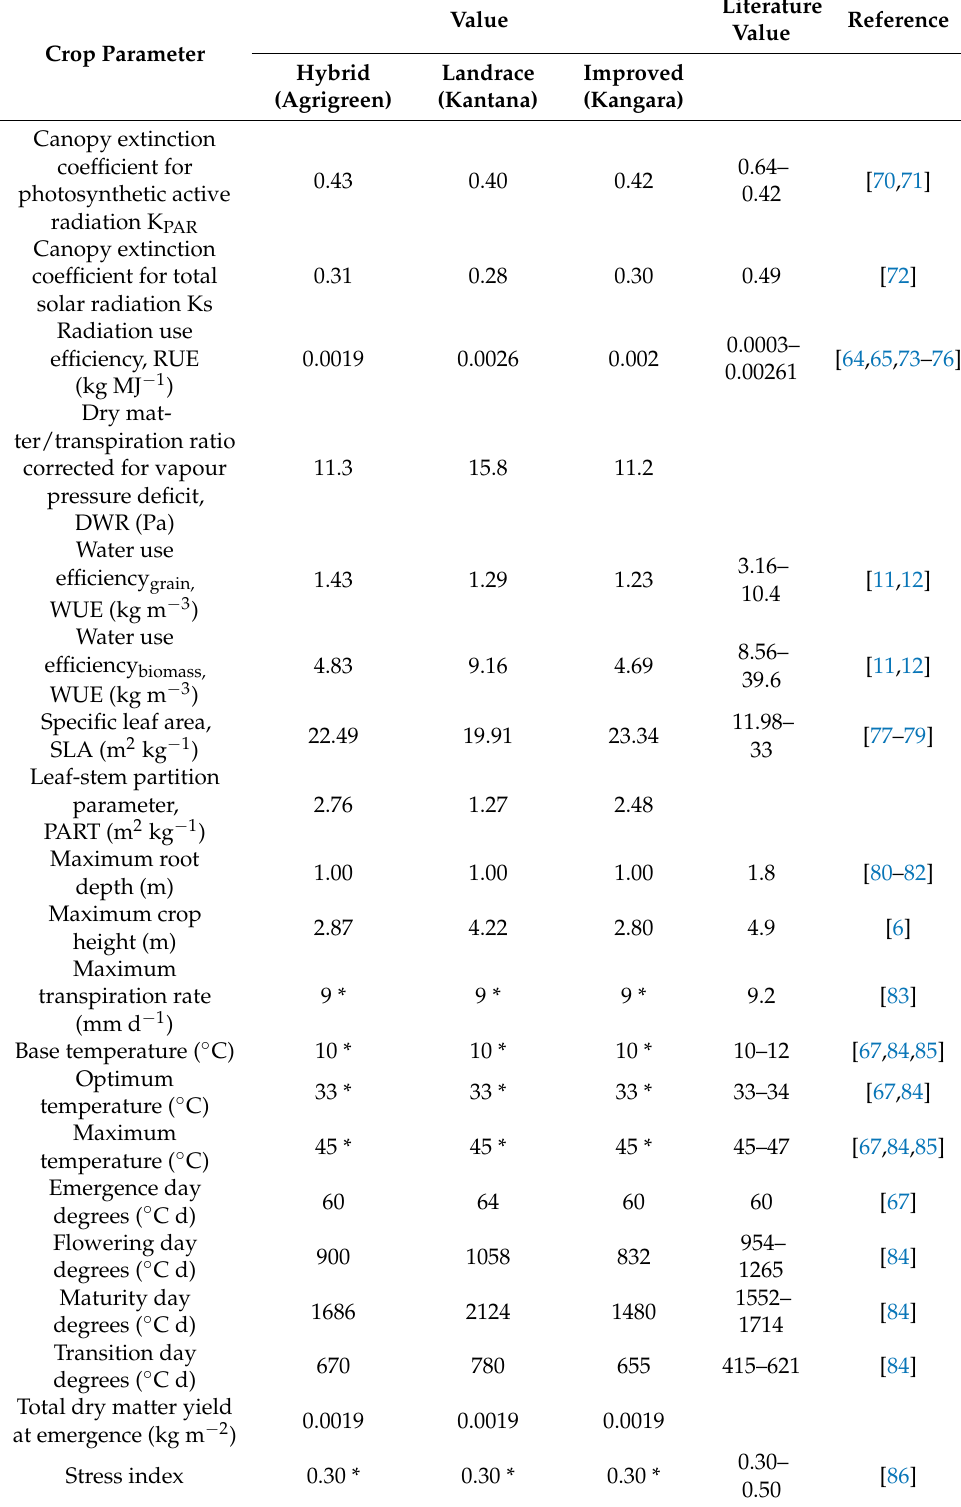
Table 3. Measured crop-specific growth parameters for three pearl millet varieties: Hybrid (Agrigreen), landrace (Kantana) and improved (Kangara) and other values were sourced from literature